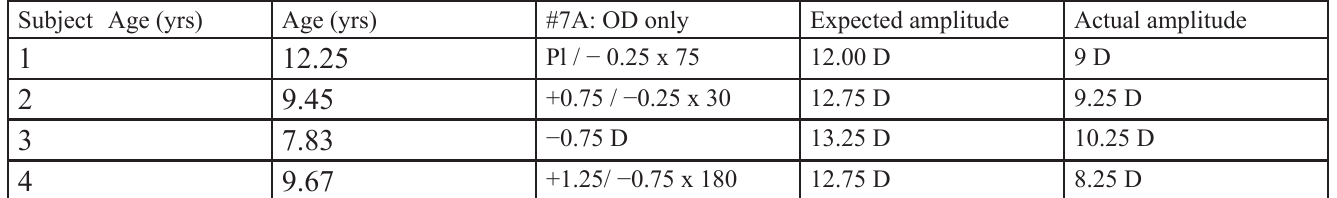
Table 1. Ages for the four subjects and their subjective refractions, expected and actual amplitudes of accommodation are included.